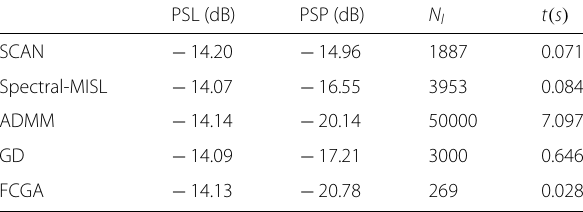
Table 2 Comparison of the performance parameters between the five